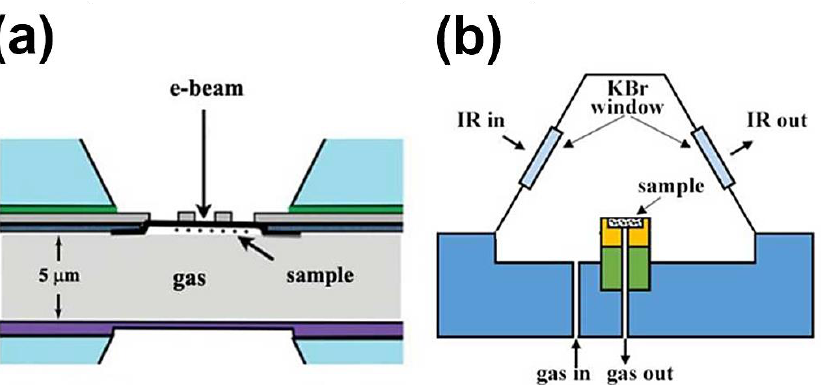
Figure 5. Schematic cross section view of the assembled gas cell with sample loaded for in situ STEM ( a ) and in situ FTIR ( b ). Reprinted with permission from [108], American Chemical Society, 2017.